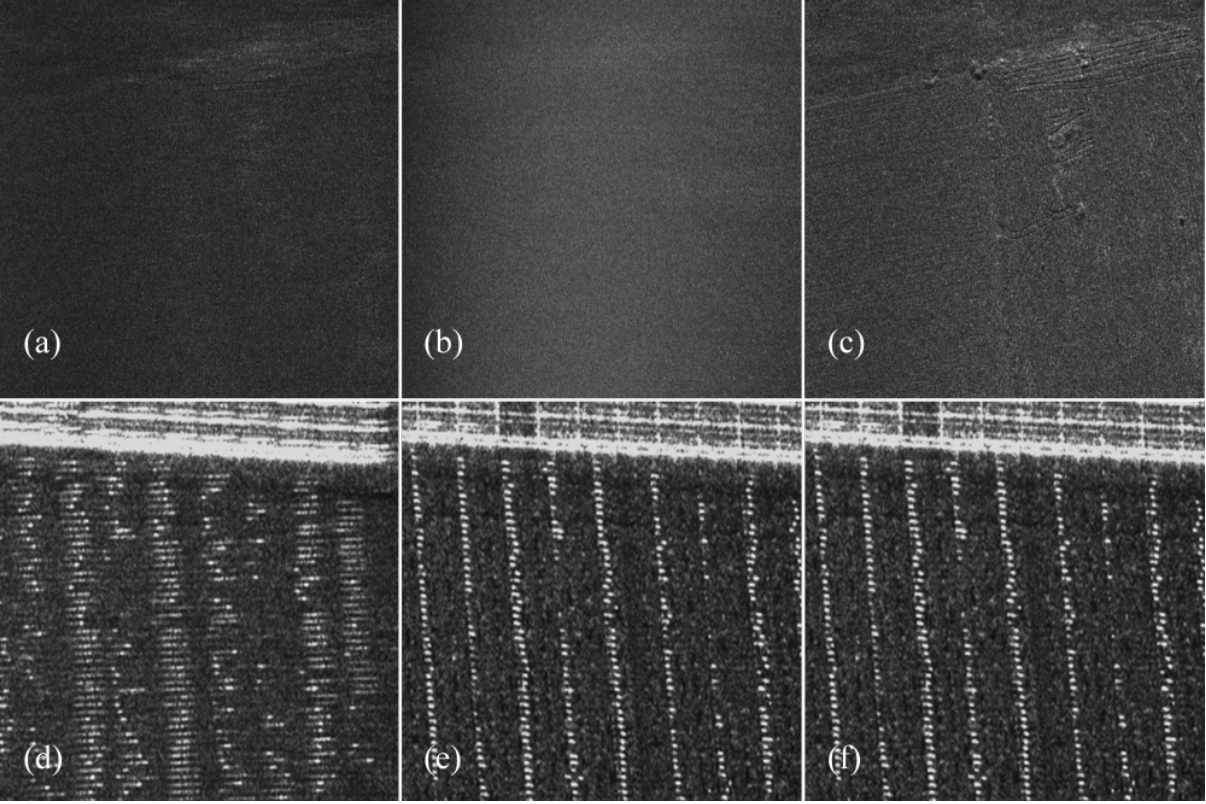
Figure 7. Enlarged autofocus imageries of imageries 5 (cid:13) and 6 (cid:13) . No autofocus ( a , d ), PGA autofocus ( b , e ), the proposed approach ( c , f